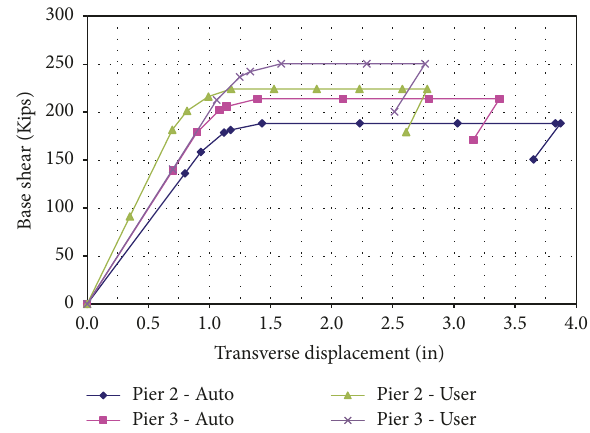
Figure 6: Transverse pushover capacity curve of Bridge #2-E and Bridge